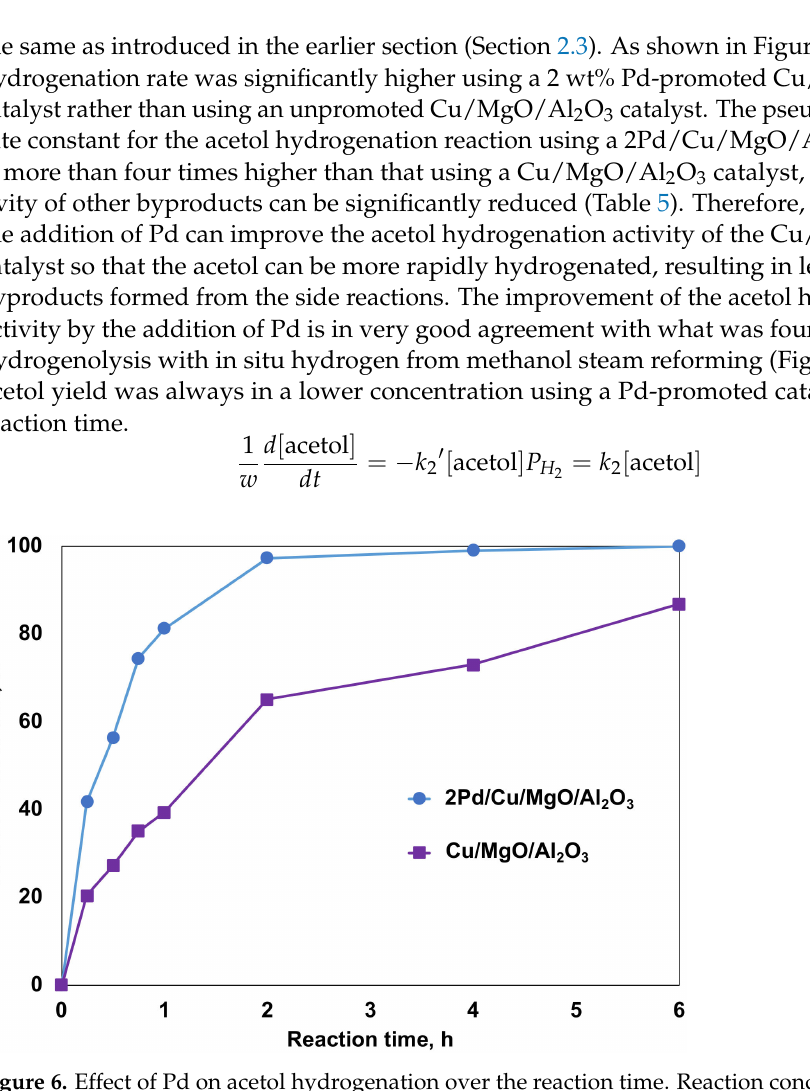
Figure 6. Effect of Pd on acetol hydrogenation over the reaction time. Reaction conditions: 10 wt% with respect to acetol weight. Cu/Mg/Al (molar) = 22.5/67.5/10. Table 5. Effect of Pd on acetol hydrogenation 1